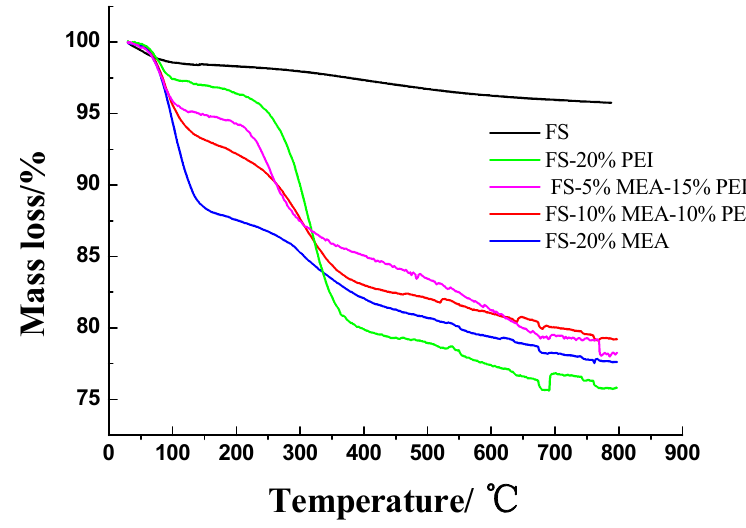
Figure 6. TG analysis of FNG-II silica (FS) before and after loading amine.